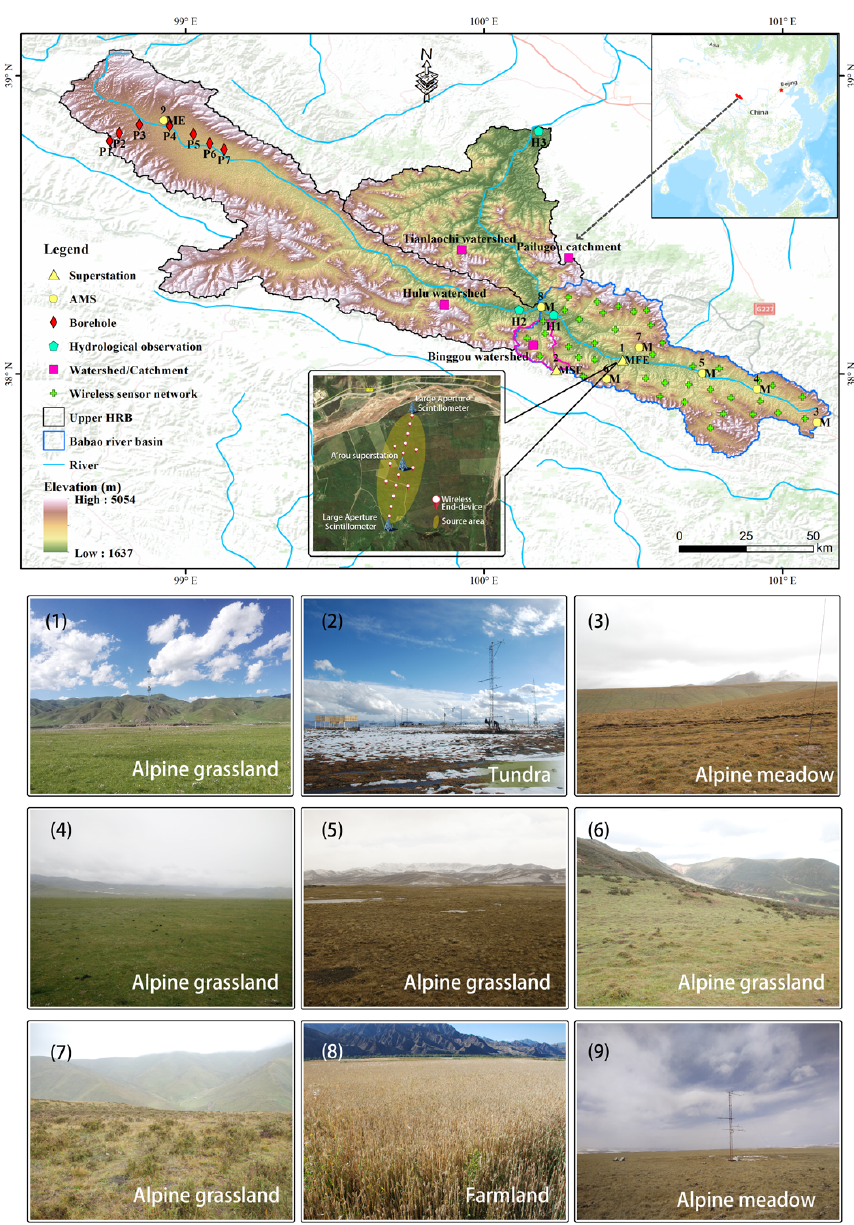
Figure 1. The integrated hydrometeorological, snow and frozen-ground data observation network located at the study site. The observation network includes seven meteorological stations (M), one frozen-ground superstation (F) and one snow superstation (S). The frozen-ground and snow superstation observe the meteorological variables, evapotranspiration (E), and water and carbon fluxes, while the Dashalong station (No. 9) observes evapotranspiration by eddy covariance. The other observation watersheds (purple square) in the upper HRB include the Hulu watershed (Chen et al., 2014), Pailugou watershed (He et al., 2012), Tianlaochi watershed (Peng et al., 2014) and Binggou watershed (Li and Wang, 2011). There are nine boreholes in the west for permafrost observation (red diamond, Peng et al., 2016). In addition, 40 wireless sensor nodes (end device, green cross) were designed to observe soil moisture and temperature in a sub-basin and the Babao River Basin (bounded by purple polygons, more details and data can be found in Jin et al., 2014). Additionally, there are three hydrological sites in the upper HRB where the runoff was measured (blue circle). In the zoomed-in subfigure at the bottom, a pair of large aperture scintillometers (LASs) are shown on the north-facing and south-facing slopes of the A’rou frozen-ground superstation, in the middle of which 16 wireless end devices (yellow dots) were installed for soil moisture and temperature measurements. To illustrate the ecosystems in the study area, nine typical landscapes are presented as listed in Table